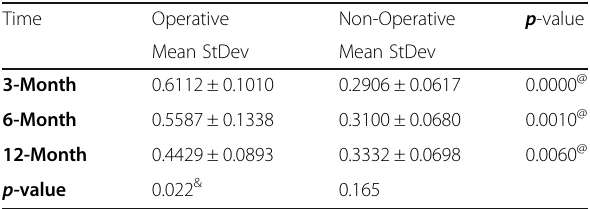
Table 2 Total Knee Standardized Uptake Value